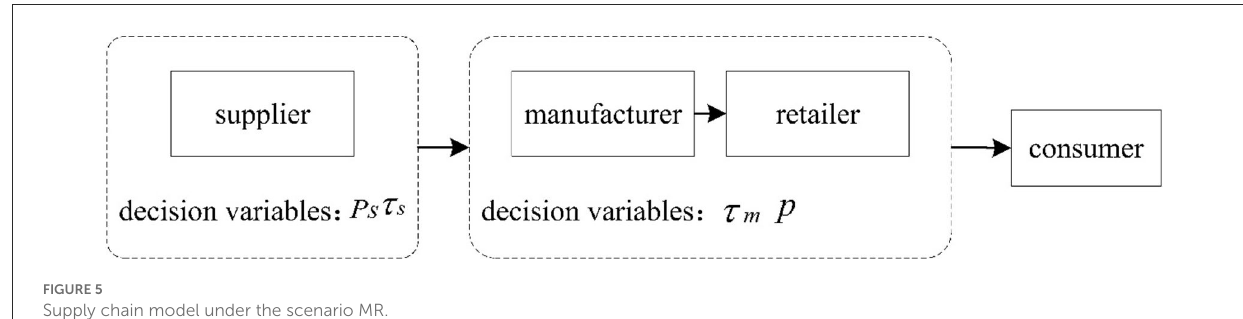
FIGURE5 Supply chain model under the scenario MR.